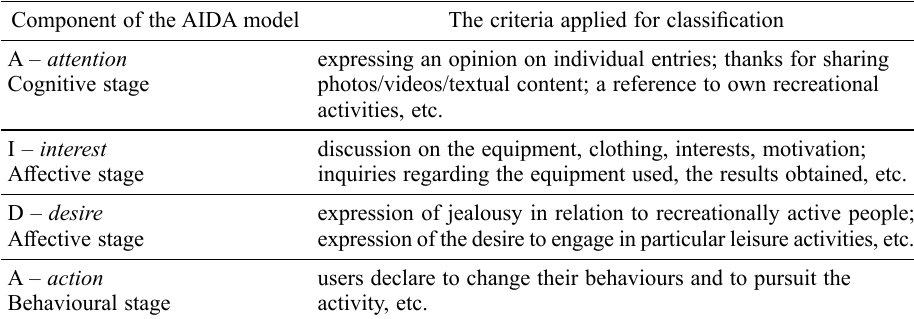
Table 2. Criteria for classifying the comments in the analysed blogs based on Strong (1925) Component of the AIDA model The criteria applied for